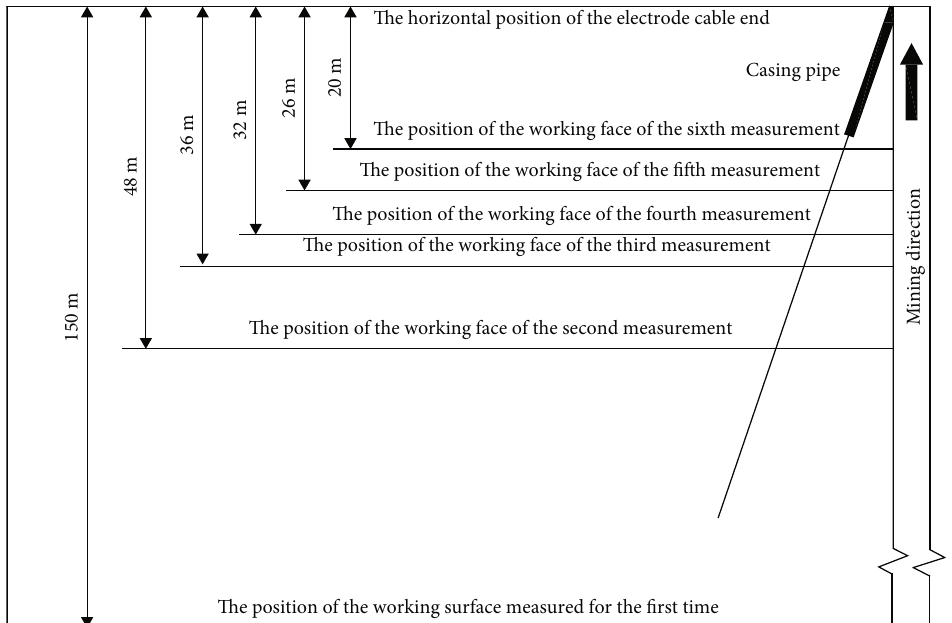
48 m, 36m, 32 m, 26 m, and 20m, respectively. As shown in Figure 18, the characteristics of apparent resistivity along the cable are observed under the condition of one electrode dis- tance, two times the electrode distance, and three times the electrode distance.